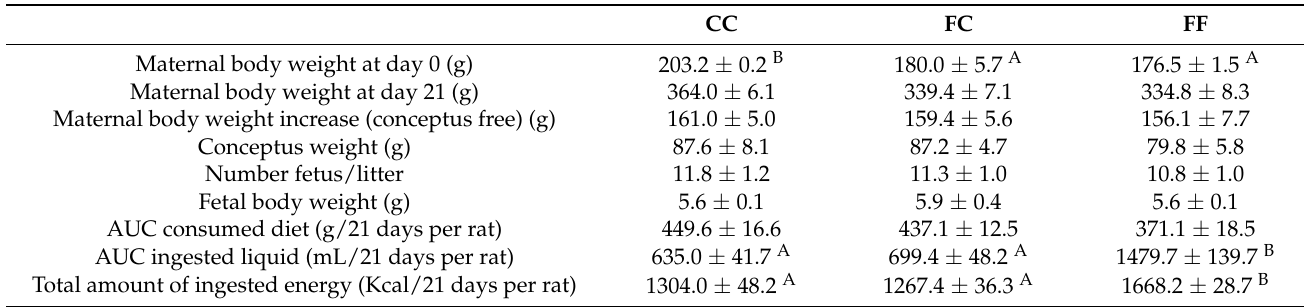
Table 1. Body weight, food, and liquid ingestion in pregnant rats from fructose-fed mothers subjected (FF) or not (FC) to fructose intake throughout pregnancy and control mothers